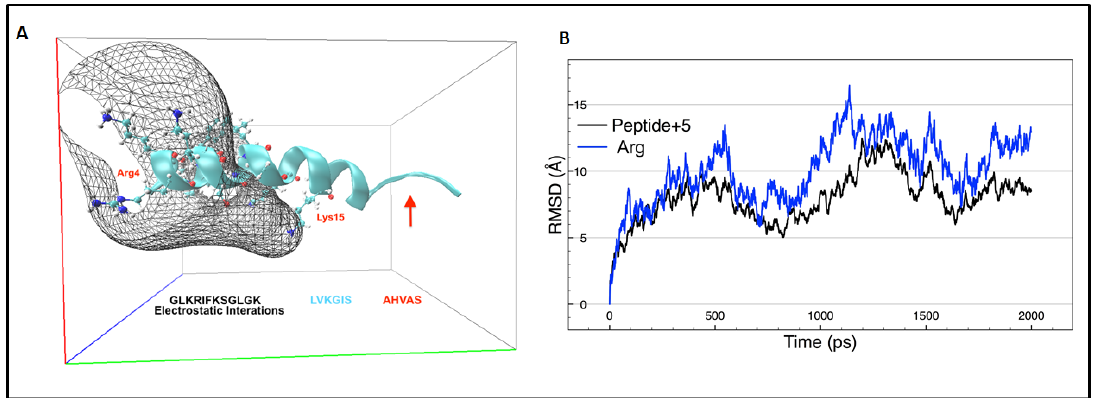
Figure 3. ( A ) Smoothed electrostatic potential grid model taken during 2000 ps of molecular dynamics simulation and characterisation of the residues and sequence involved in the electrostatic interaction. ( B ) Root-mean-square deviation (RMSD) against time in picoseconds (ps); the black line represents the behaviour of all residues and the blue line represents the behaviour of only Arg4.